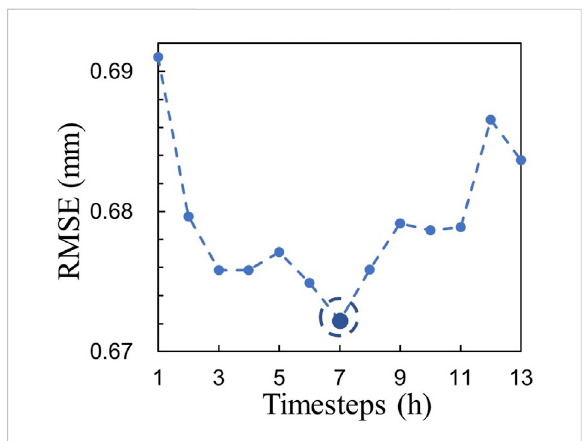
FIGURE 5 Average RMSE of the training sets of all LSTM-RN models at different